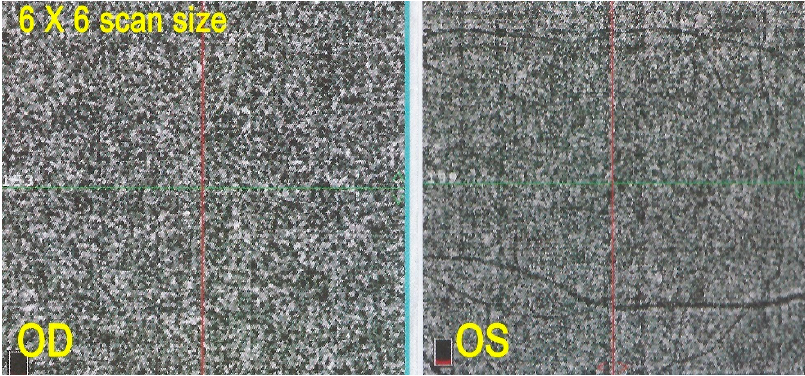
Figure 15. OCT-A in AZOOR patient 2. Capillary plane: no capillary drop out ODS. Table 2. Multimodal imaging of AZOOR and clinicopathological correlations.